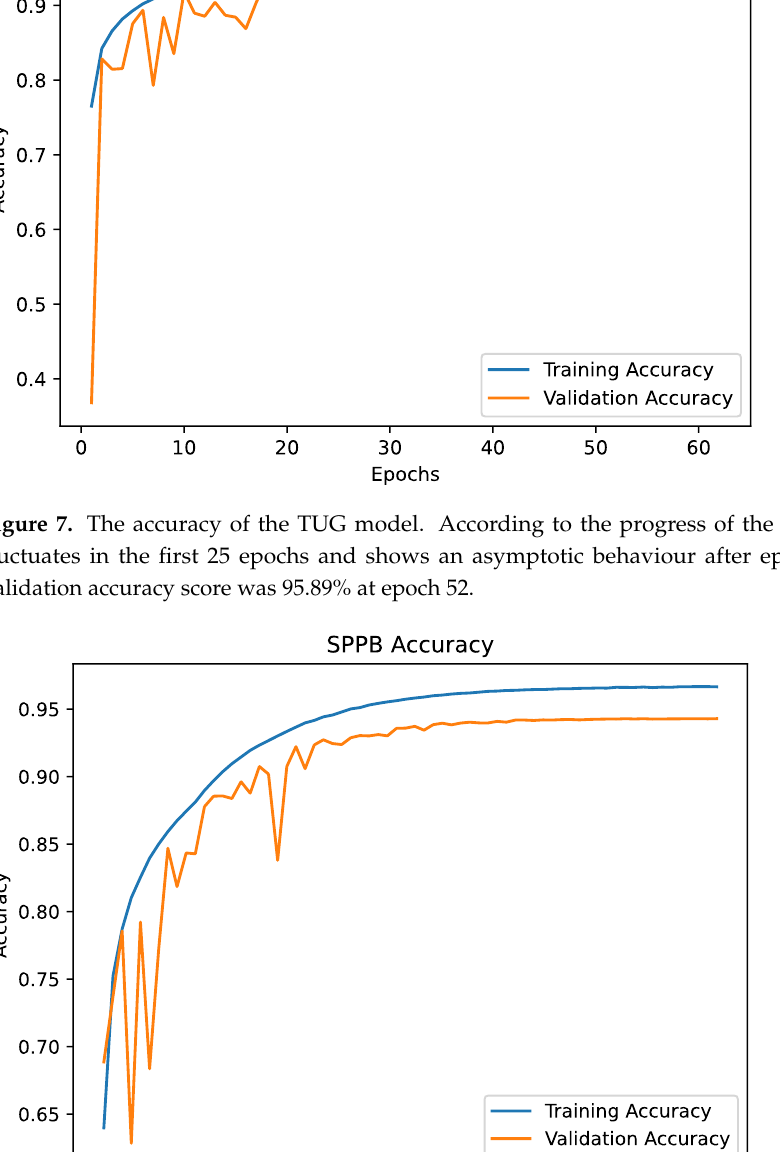
Figure 8. The accuracy of the SPPB model. According to the progress of the loss, the accuracy Figure 6. The accuracy of the SPPB model. fluctuates in the first 25 epochs and shows an asymptotic behaviour after epoch 25. The best validation accuracy score was 94.29% at epoch 67. According to the progress of the loss, the accuracy fluctuates in the first 25 epochs and Table 6. The accuracy on the test set and the two excluded shows an asymptotic behaviour after epoch 25.